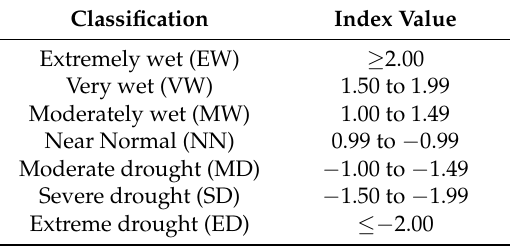
Table 2. Drought categories based on Standardized Precipitation Index (SPI)